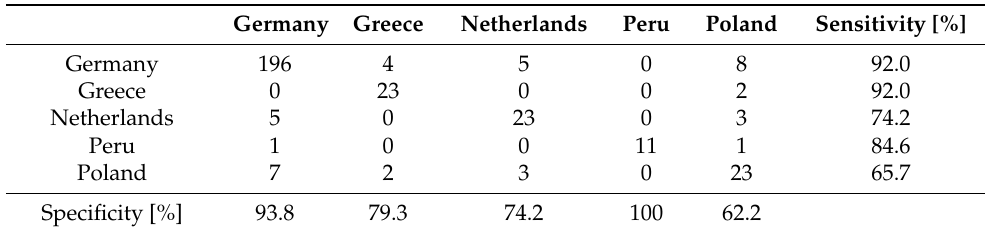
Table 1. Confusion matrix for the classification of the geographical origin.